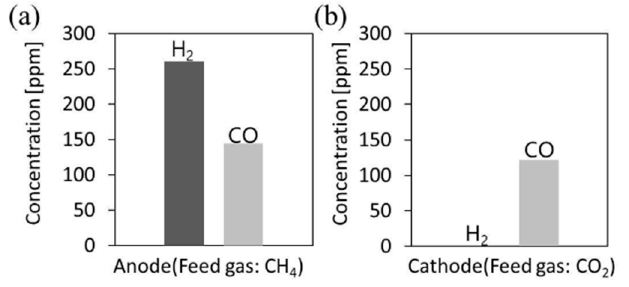
Figure 39. Products obtained in ( a ) the anodic side and ( b ) the cathodic side. The feed gas was CH 4 into the anodic side and CO 2 into the cathodic side. The reaction temperature was 600 °C and UV light was irradiated onto both sides. Reprinted from [52]. Copyright 2020 by John Wiley & Sons, Inc.